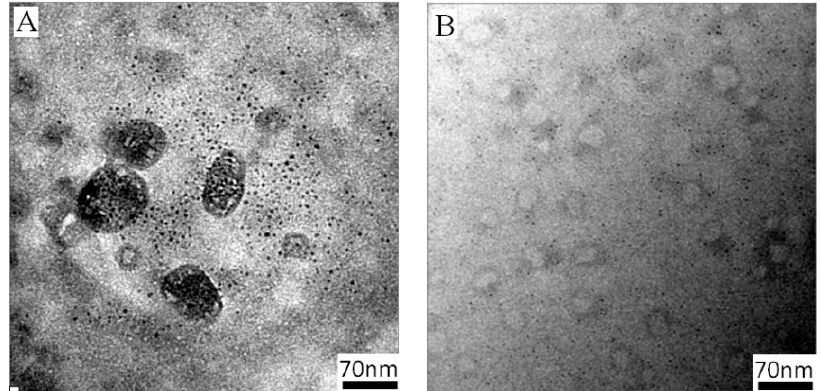
Figure 5. TEM images of PICsome 20 with 0.1 mg/mL AuCl 4 − at 25 °C ( A ) and 40 °C ( B ).